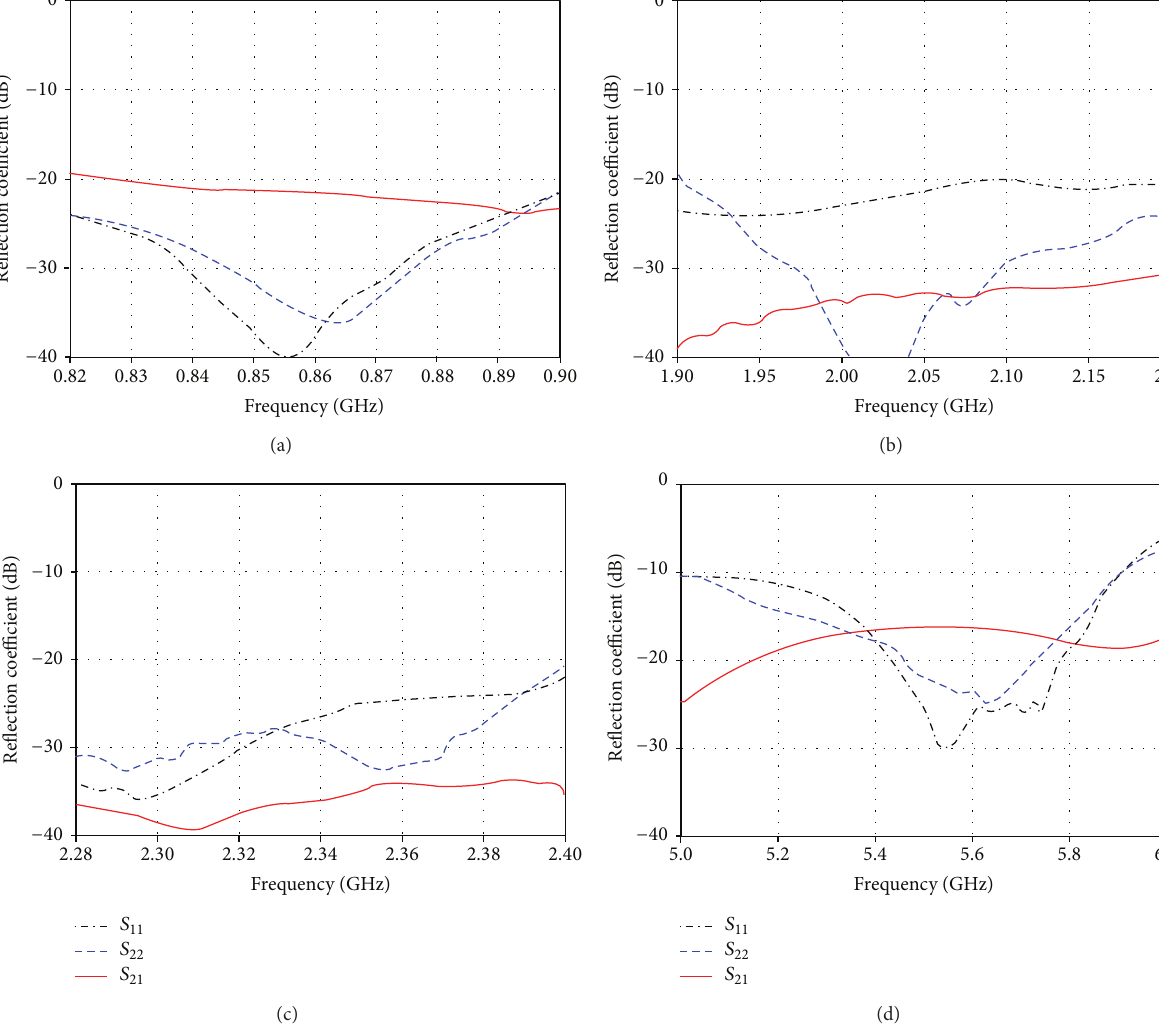
Figure 8: Measured return loss and isolation characteristic of the multiband array: (a) Band 1, (b) Band 2, (c) Band 3, and (d) Band